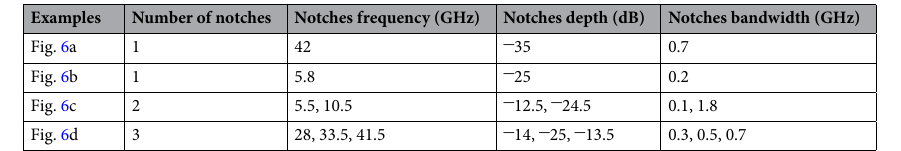
Table 3. Desired input targets for four S-parameters, which are presented in Fig. 6.